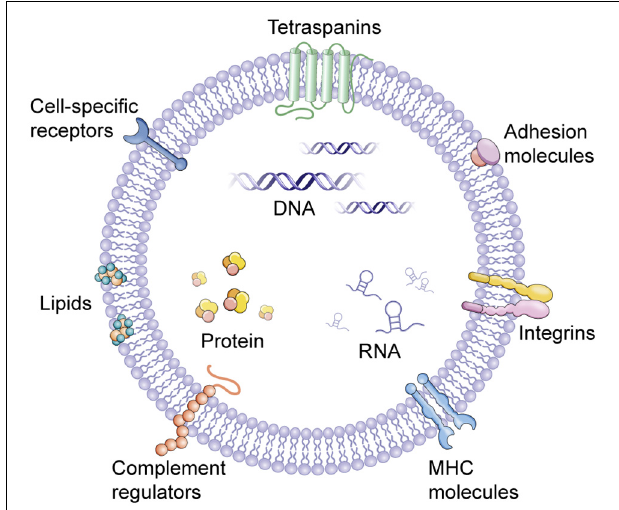
FIGURE 1 | Extracellular vesicles (EVs). EVs contain several types of molecules, proteins, DNA, mRNA, lncRNA, and miRNA, some of which are selectively enriched and specific to cell of origin. MHC, major histocompatibility